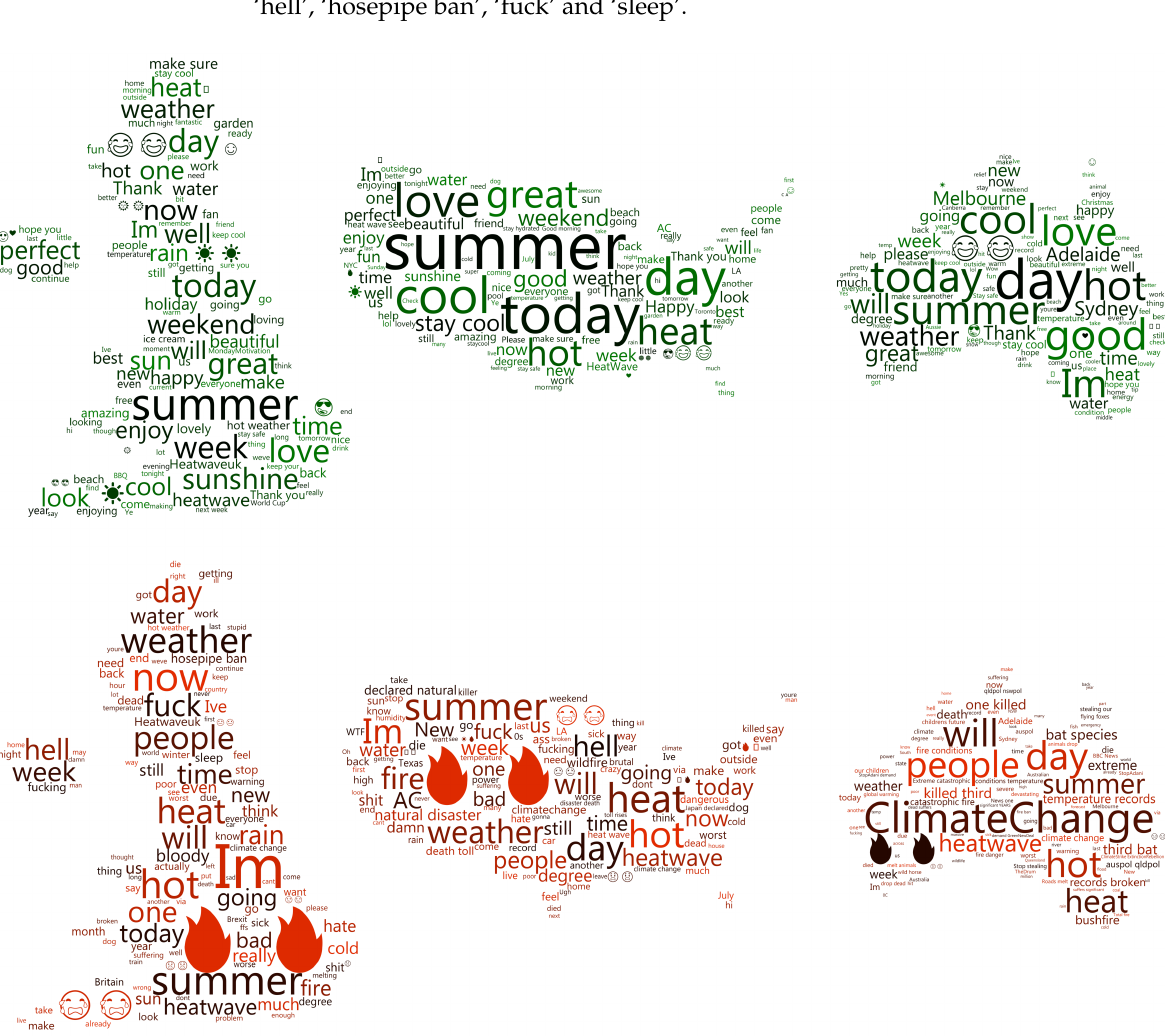
Figure 4. Word clouds showing the language used in the extremely positive ( top ) and negative ( bottom ) tweets in each country during the summer